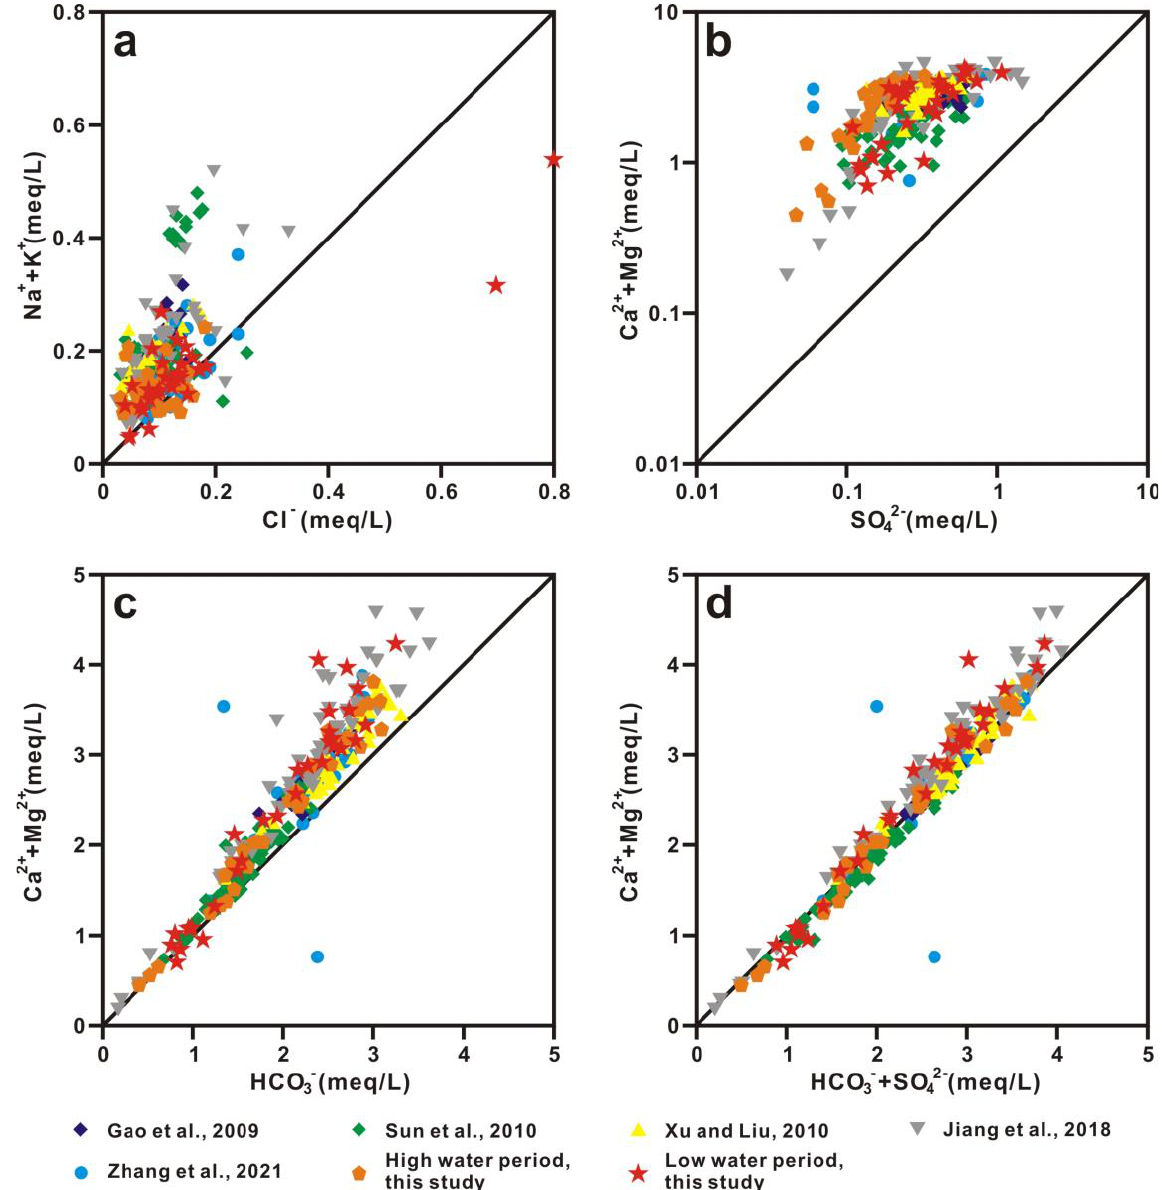
Figure 6. Plots of equivalent ratios of ( a ) (Na + + K + ) versus Cl − , ( b ) (Ca 2+ + Mg 2+ ) versus SO 42 − , ( c ) (Ca 2+ + Mg 2+ ) versus HCO 3 − , and ( d ) (Ca 2+ + Mg 2+ ) versus HCO 3 − + SO 42 − in Xi River drainage waters. Refs. (Gao et al., 2009; Sun et al., 2010; Xu and Liu, 2010; Jiang et al., 2018; Zhang et al.; 2021) are cited in figure